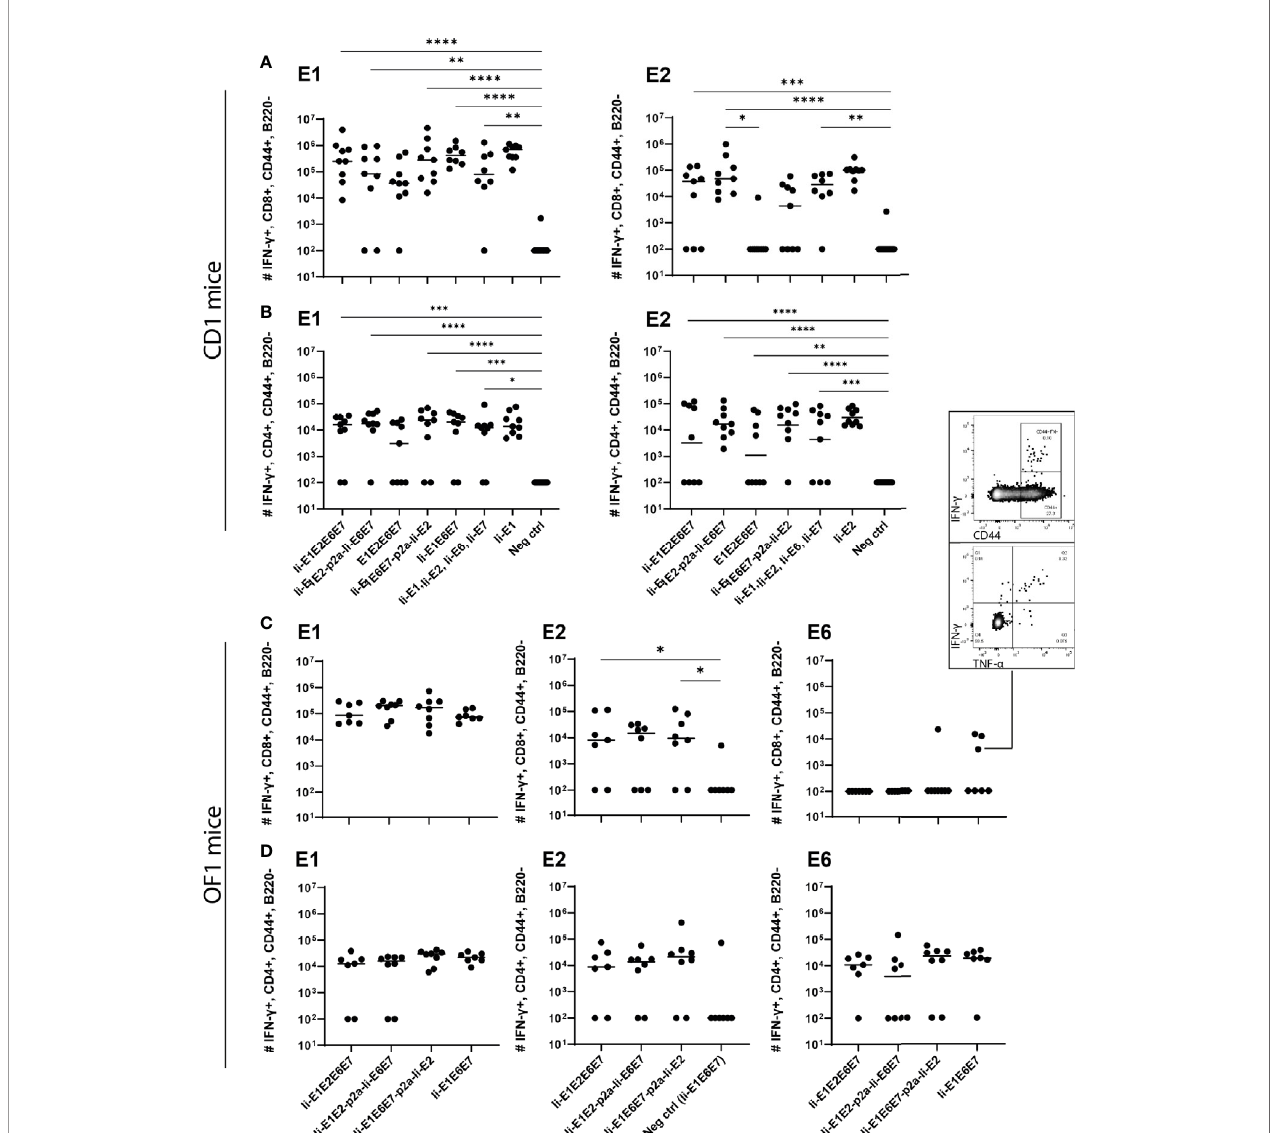
FIGURE 5 | Immunization of mice with adenovirus vectors induces potent cellular immune responses. CD1 mice (A, B) , or OF1 mice (C, D) were immunized with rAd vaccine (2×10 7 IFU) encoding the various MfPV3 early antigens as indicated. Mice were sacri fi ced on day 14, spleens were harvested and CD8 + and CD4 + T-cell immune responses against E1, E2, E6, and E7 were measured using ICS and fl ow cytometry. Negative control groups consist of all mice immunized with rAd encoding antigens not matching the peptide pools used for in vitro restimulation, respectively. Each symbol represents one mouse; a representative mouse depicted (C) , shows a CD44+IFN- g + population. The horizontal bar represents the median. Positive control samples (mice vaccinated with rAd containing only the relevant antigen linked to Ii) are not included in the statistical analysis (multiple comparison adjustment). *p < 0.05; **p < 0.01, ***p < 0.005, ****p <